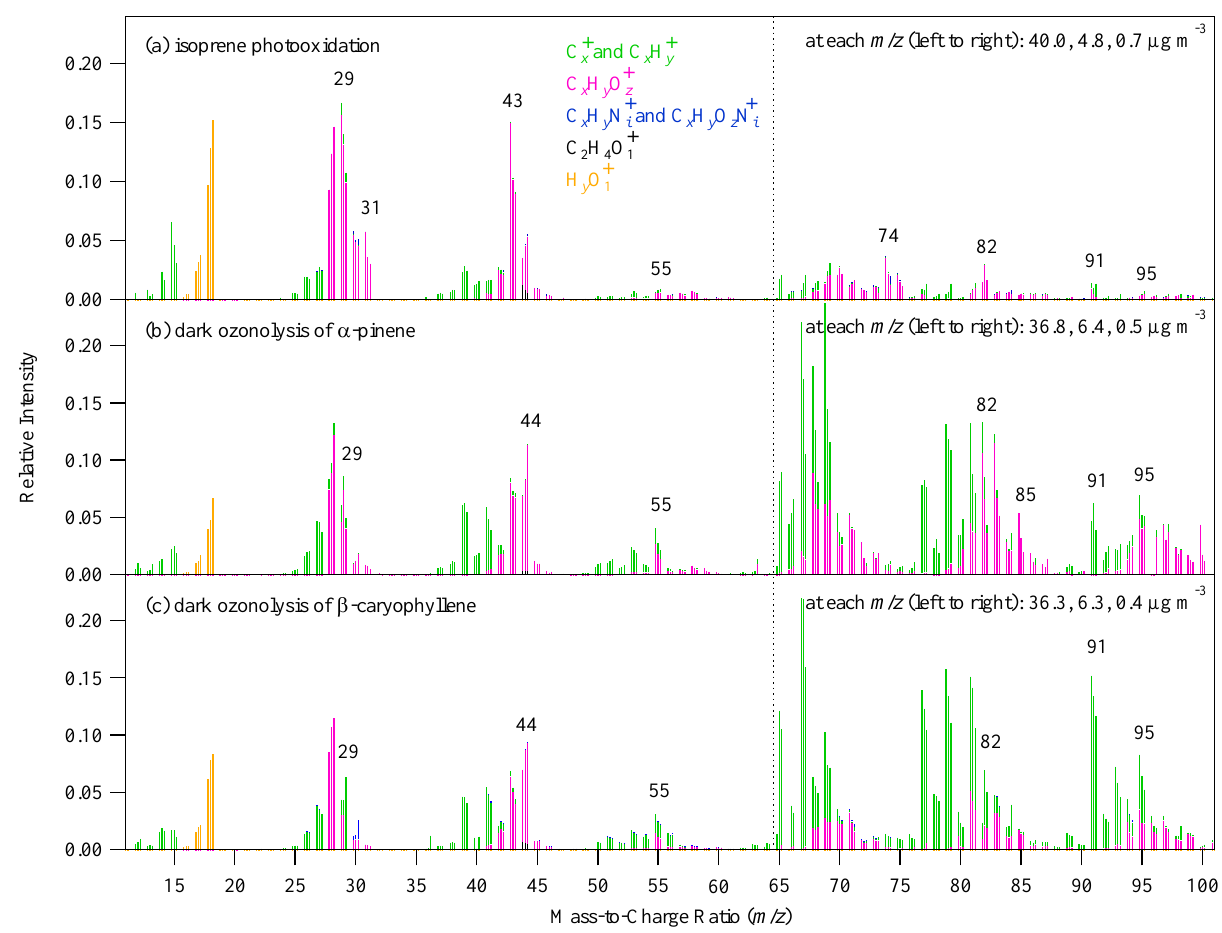
Figure 4. High-resolution mass spectra of secondary organic material produced in the Harvard Environmental Chamber by the oxidation of isoprene, α -pinene, and β -caryophyllene. The NO x concentration was measured as <1ppbv during these experiments and was estimated later as <70ppt for typical operating of the HEC (Liu et al., 2013). The relative intensities of ions having m/z ≥ 65 were multiplied by 10. The intensities at each m/z represent three experiments that were performed at different SOM particle mass concentrations. A single intensity bar is color-coded by the contribution of different ion families (i.e., fragments containing C, H, O, or N for subscripts of x, y, z, i ≥ 1) as determined from the analysis of the high-resolution spectra (Shilling et al., 2009). The relative intensities of the H y O + derived from the intensity of CO + based on calibrations described in Chen et al. (2011). 2